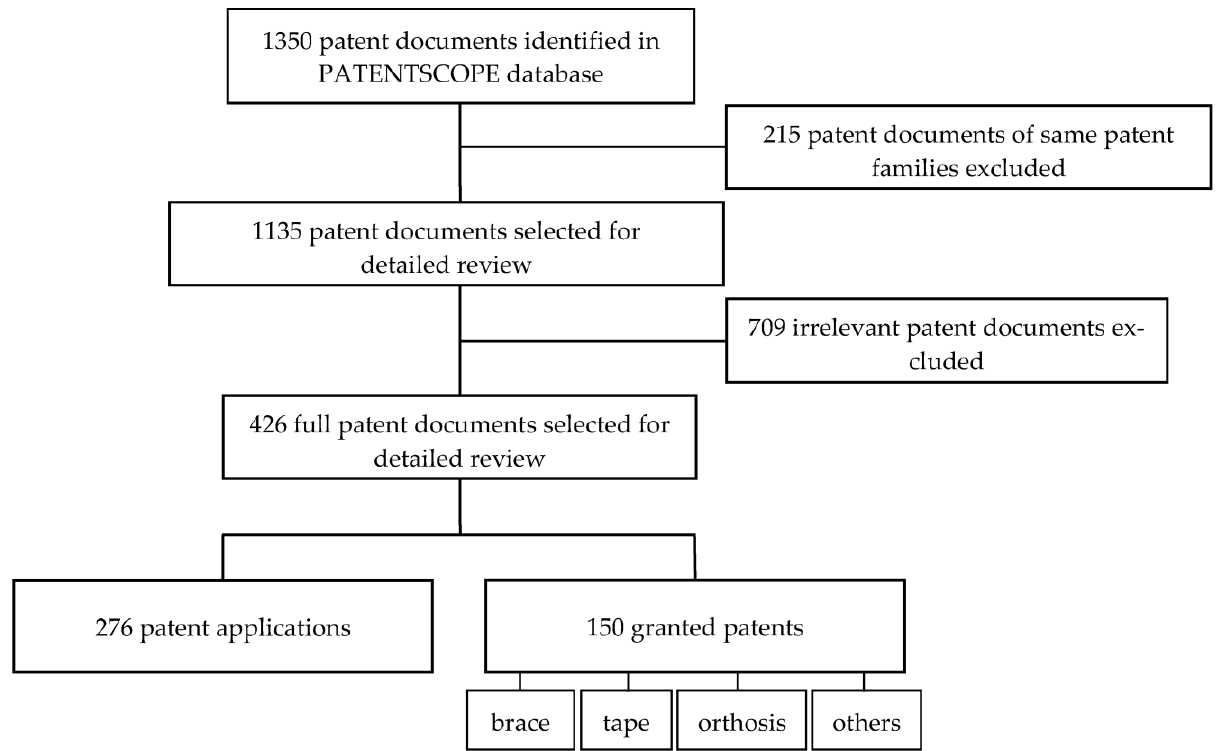
Figure 1. Flowchart to review patent results based on PRISMA Statement.